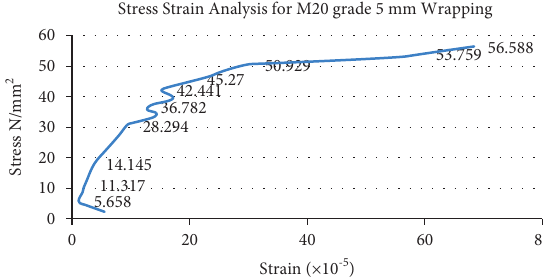
Figure 14: Stress-strain analysis for grade M20 with 5mm